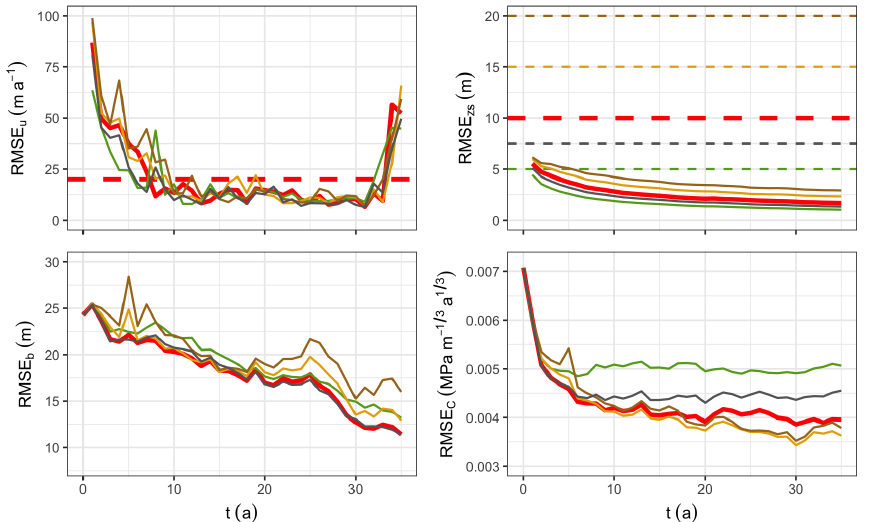
Figure 11. Sensitivity to the surface elevation observation error σ z obs : RMSEs after each analysis, computed only for x ≥ 300km for b and s = 10m shown in Figs. 3 and 9. The horizontal dashed lines C . The thick red lines correspond to the results with σ obs u = 20ma − 1 and σ z obs s correspond to the observation errors σ z obs and the results are presented with solid lines using the same colour code. σ obs u = 20ma − 1 for all s the